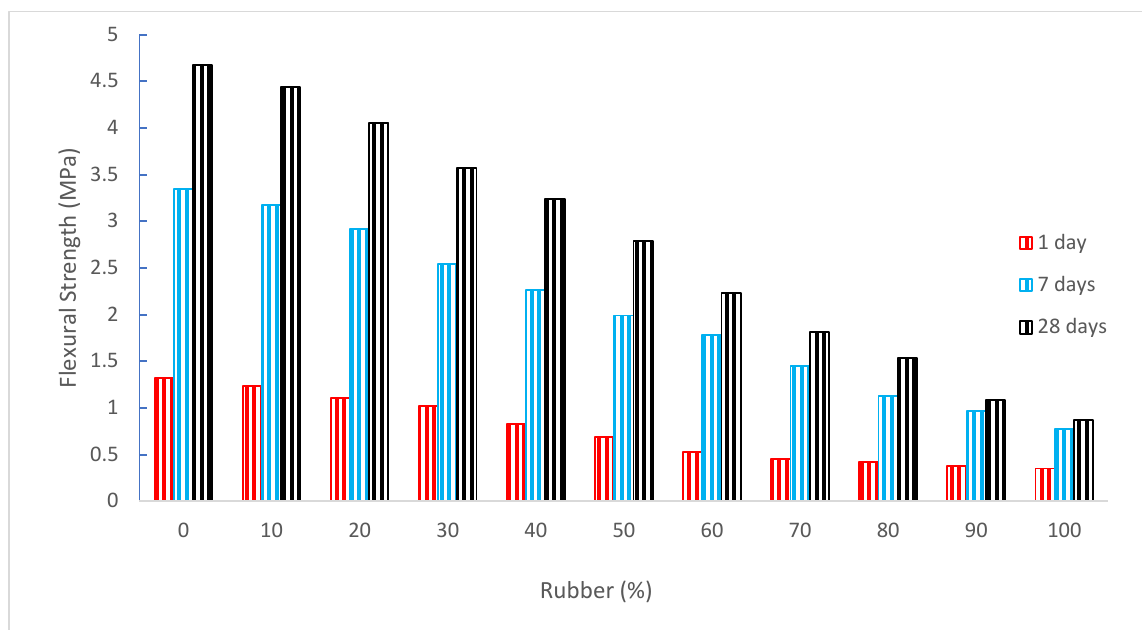
Figure 12. Flexural strength: data source [30].